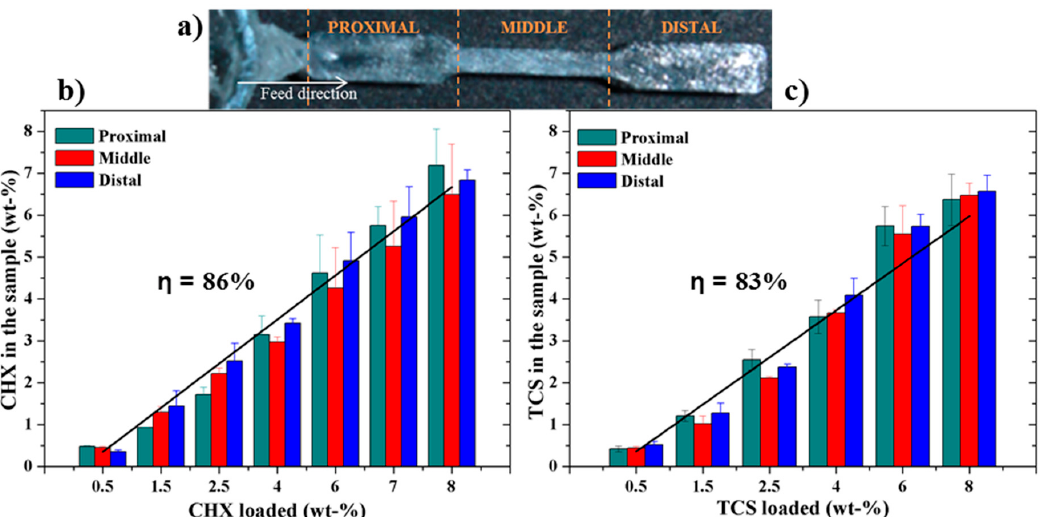
Figure 11. Schematic representation of the three selected sections for each specimen ( a ). Percentage of loaded CHX ( b ) and TCS ( c ) drugs for the three specimen sections with respect to the percentage introduced in the processing chamber.